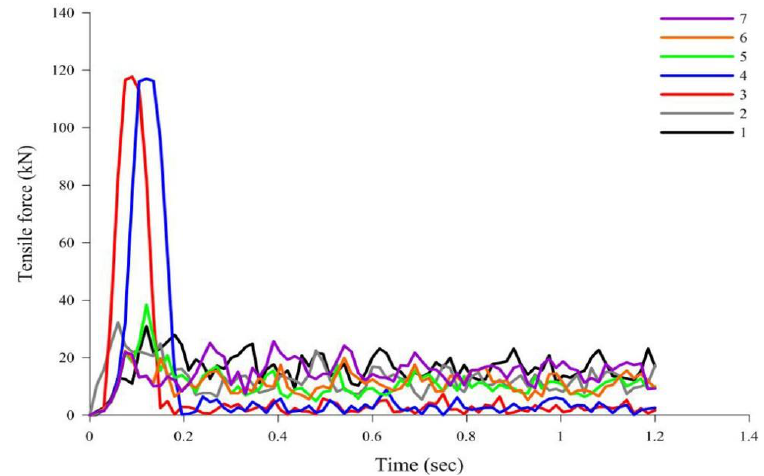
Figure 12. Tensile force acting on seven wire ropes without brake frame.